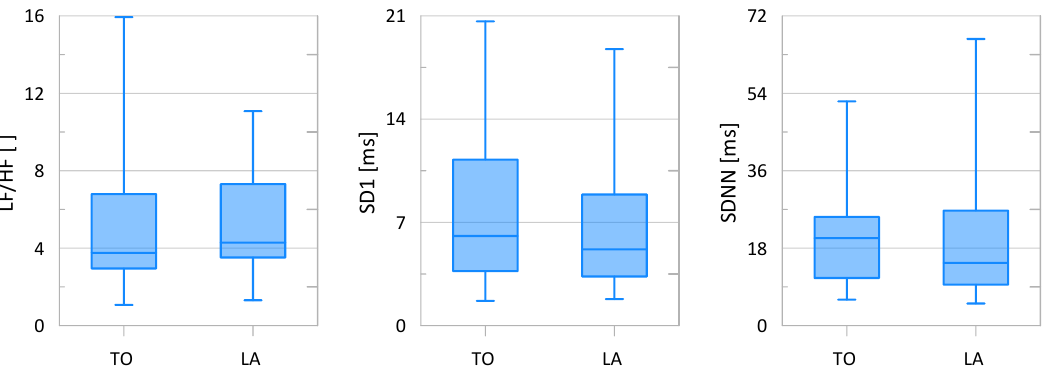
Figure 9. Values of HRV workload assessment indexes for TO and LA segment over the